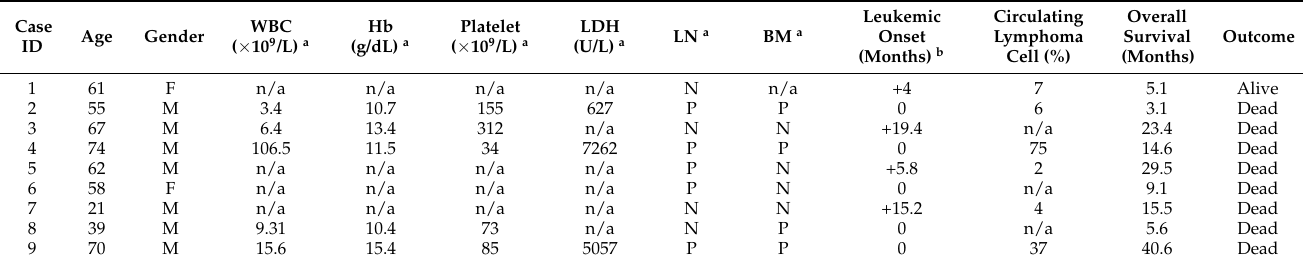
Table 1. Clinicopathological Features of 9 Patients with Leukemic ALK-negative Anaplastic Large Cell Lymphoma. Case ID